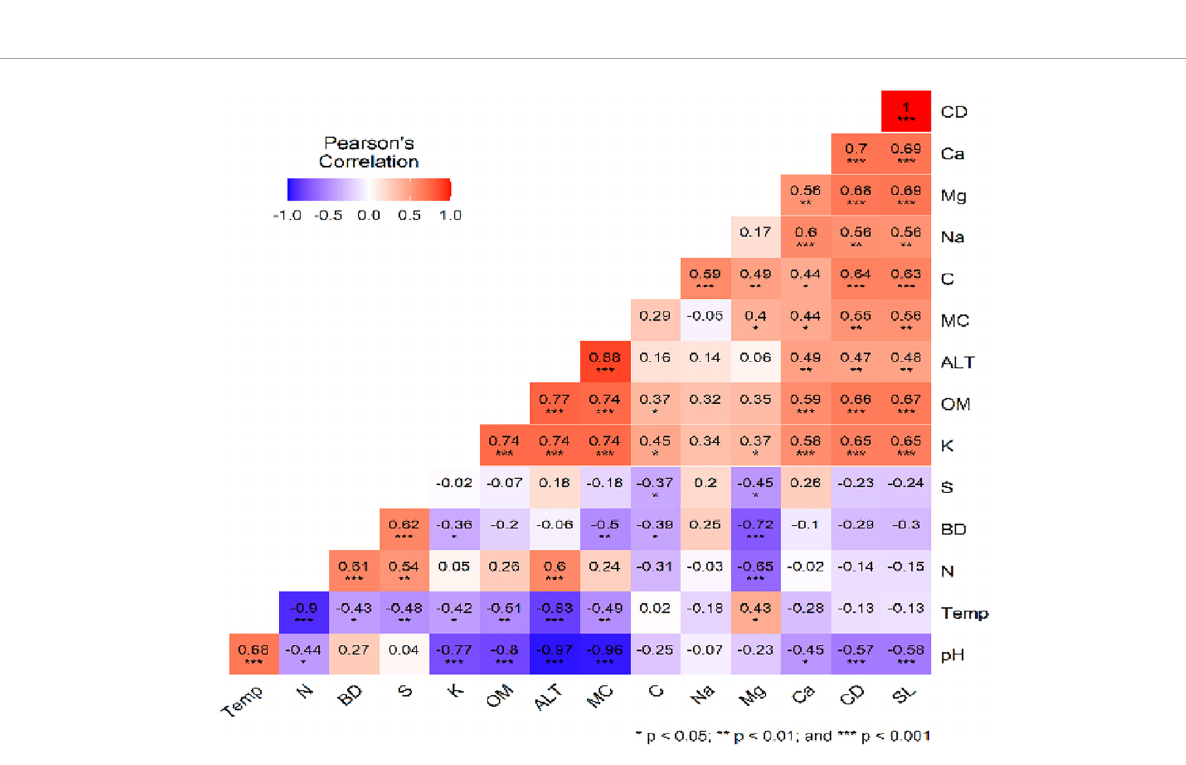
Frontiers in Forests and Global Change